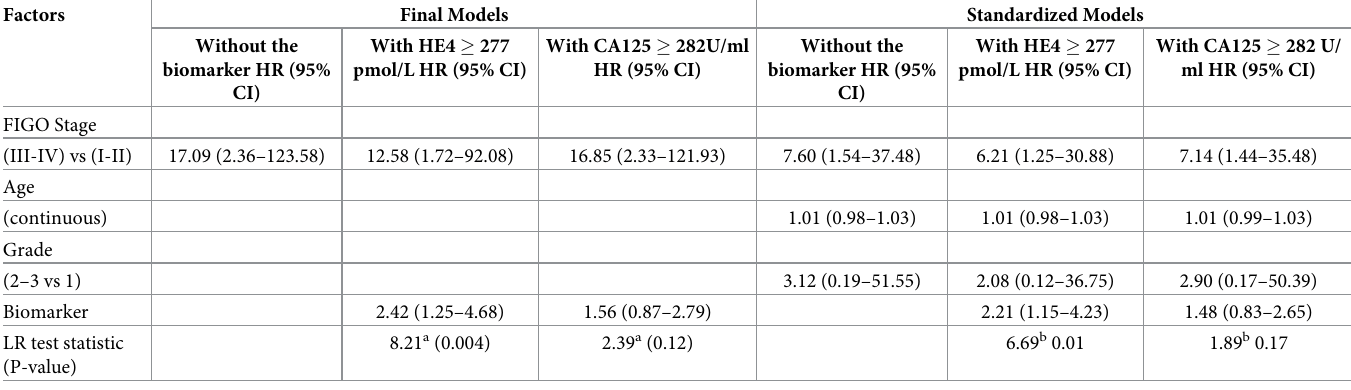
Table 5. Adjusted hazard ratios (HR) of death and their 95% confidence interval (CI) associated with preoperative plasma HE4 and CA125 in women with serous ovarian cancer (N =